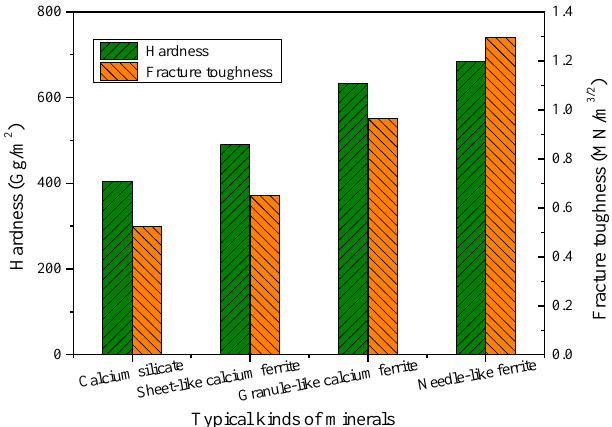
Figure 17. Fracture toughness and Vickers hardness of typical kinds of minerals.